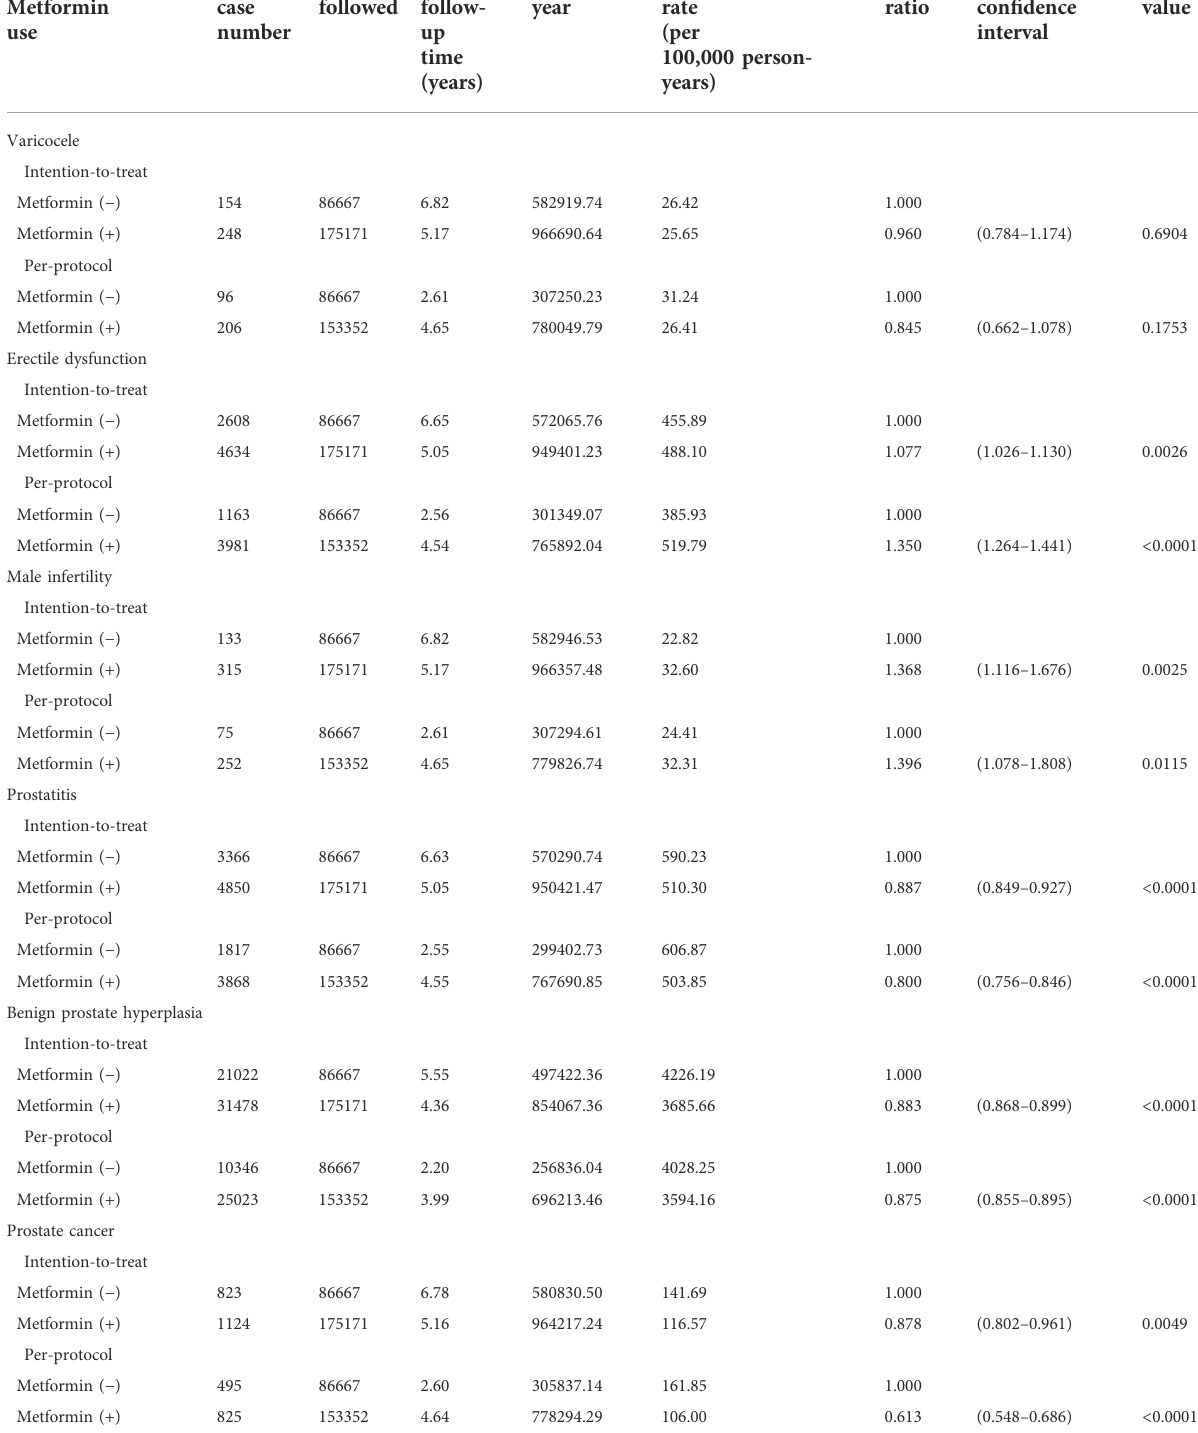
TABLE 2 Incidence rates of outcomes and hazard ratios comparing metformin initiators to non-metformin initiators. Outcome/